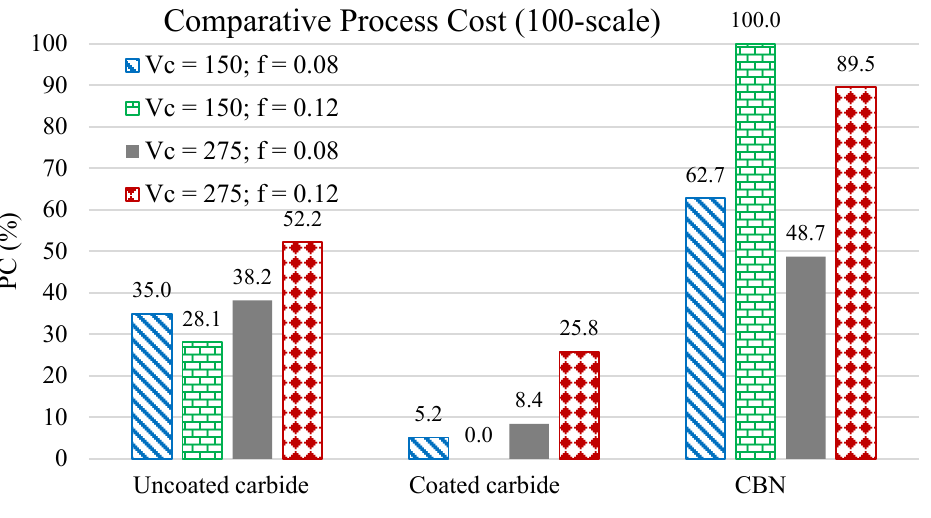
Figure 5. Process cost for the 12 experimental runs.